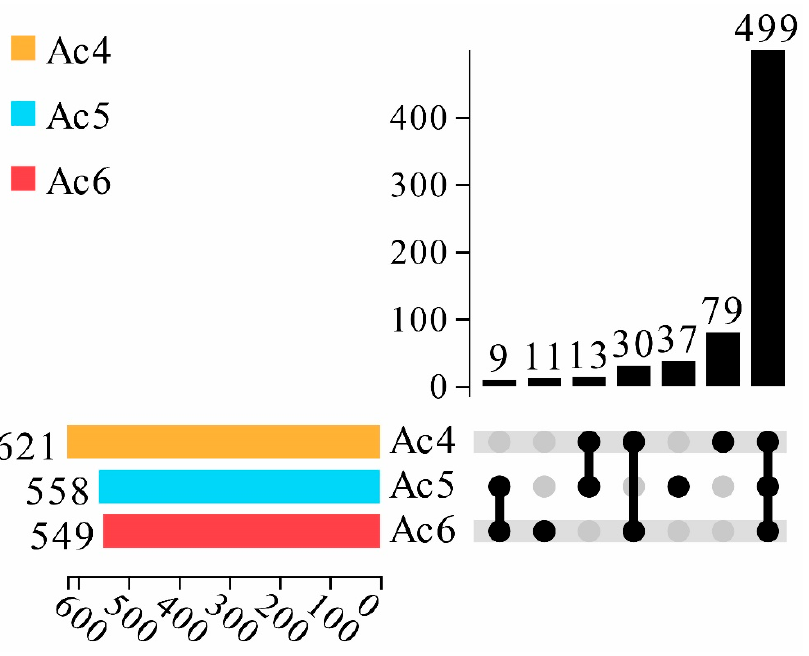
Figure 1. Upset plot of differential piRNA expression in A. c. cerana worker larval mid gut. The lower left color column indicates the number of piRNA contained in different groups; the lower right node indicates the piRNA common to each group; the connection between each group indicates the common piRNA; the teamless node indicates the unique piRNA of this group; and the number of unique and common piRNA are presented above; they are arranged in ascending order from left to right.